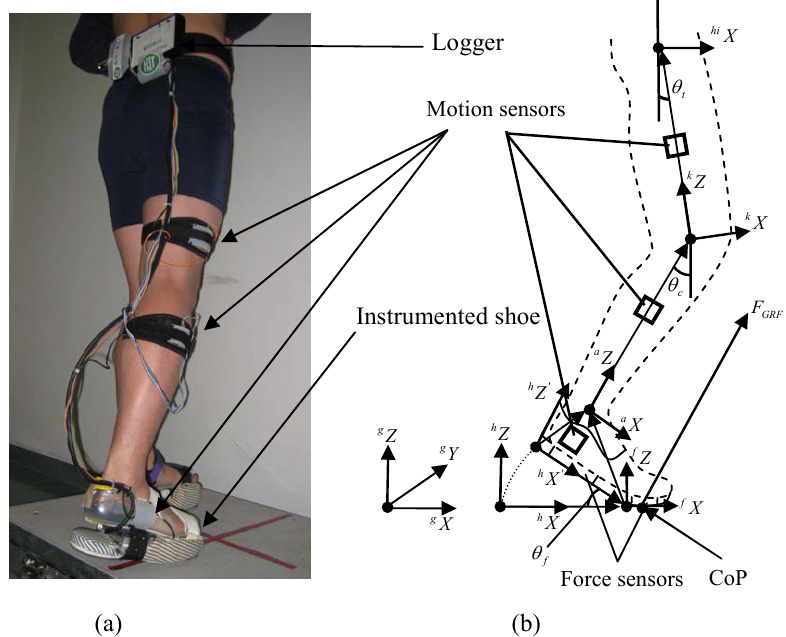
Fig.1. Diagram of lower extremity wearing the wearable sensor system. (a) Wearable sensor system. (b) Segmental model and coordinates systems of a lower